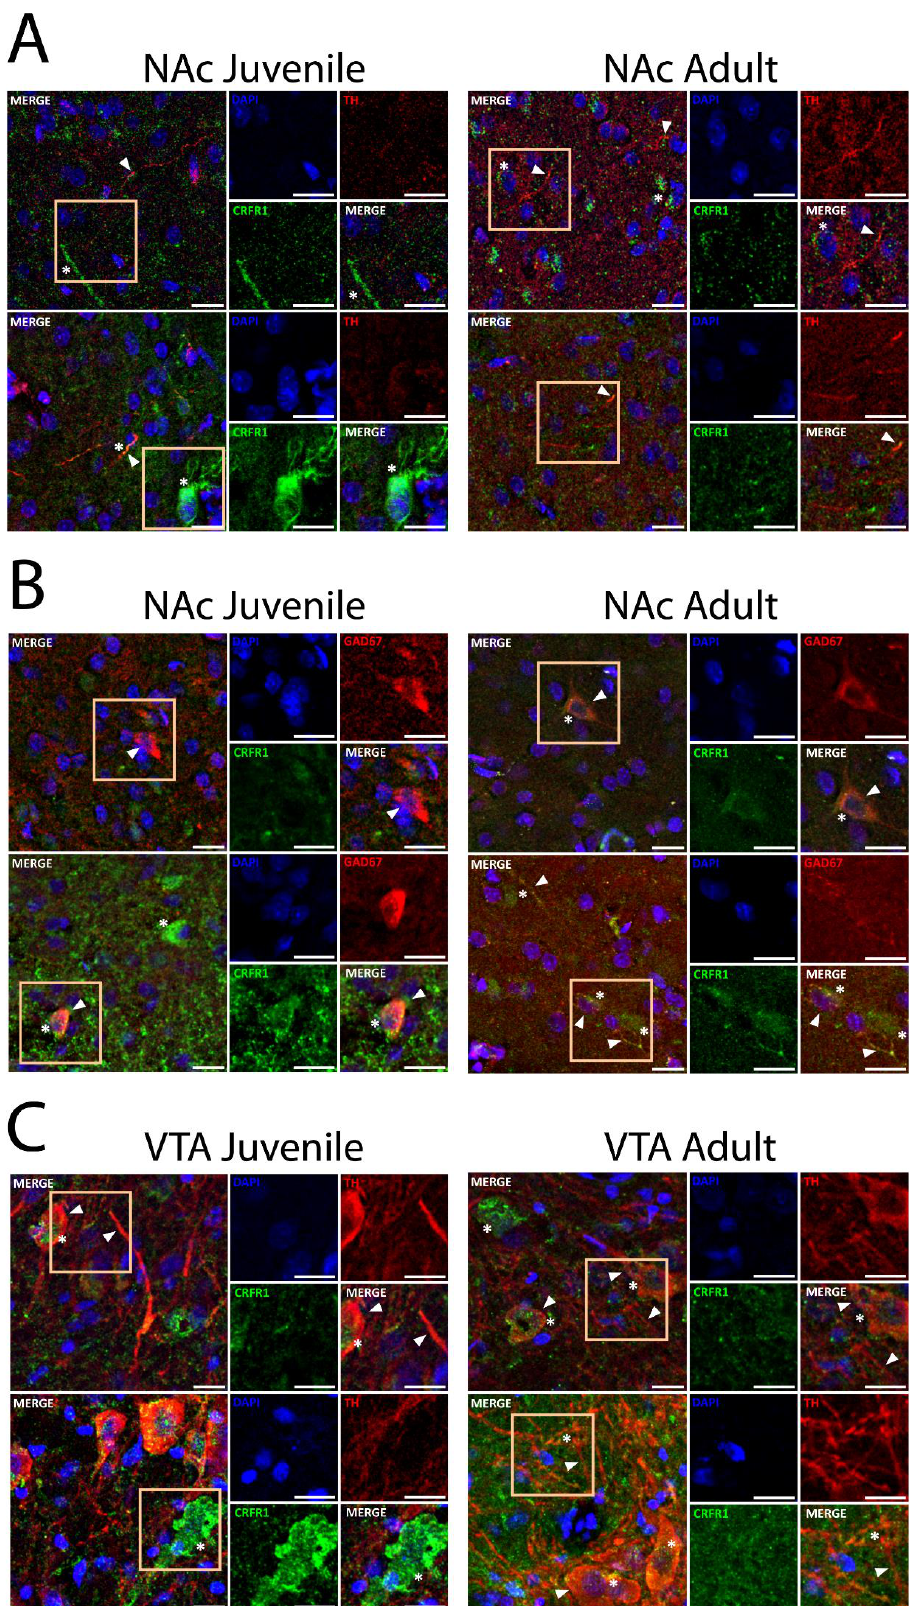
Figure 5. CRF-R1 localization in juvenile versus adult rats. Comparison of CRF-R1 localization between juvenile (left) and adult (right) rats using immunofluorescence. The right panel is a 1.3 ×